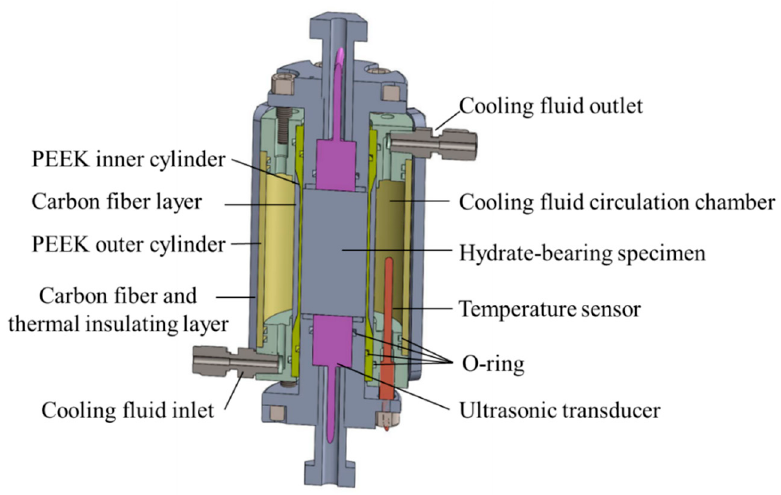
Figure 1. Schematic configuration of the ultrasonic–CT combined detection system for hydrate.